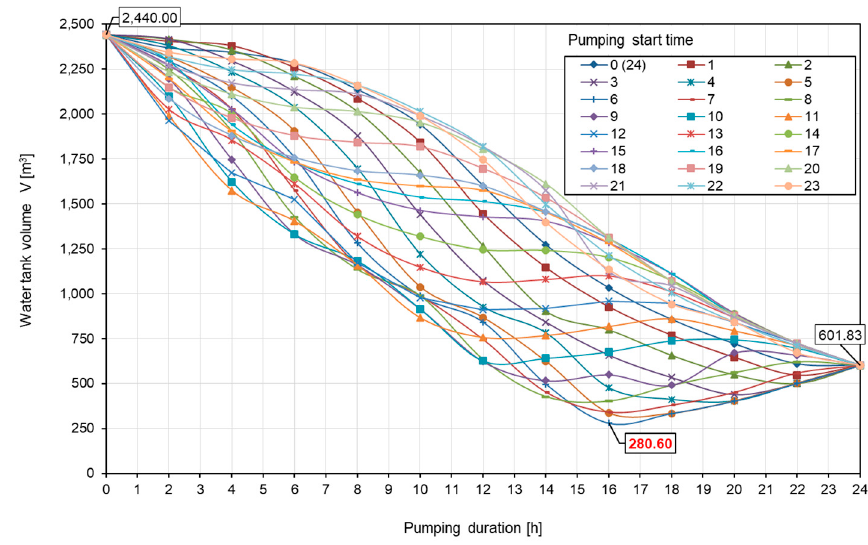
Figure 7. Changes in water tank volume V with respect to the different hours of pumping starts and different pumping durations for Variant II.